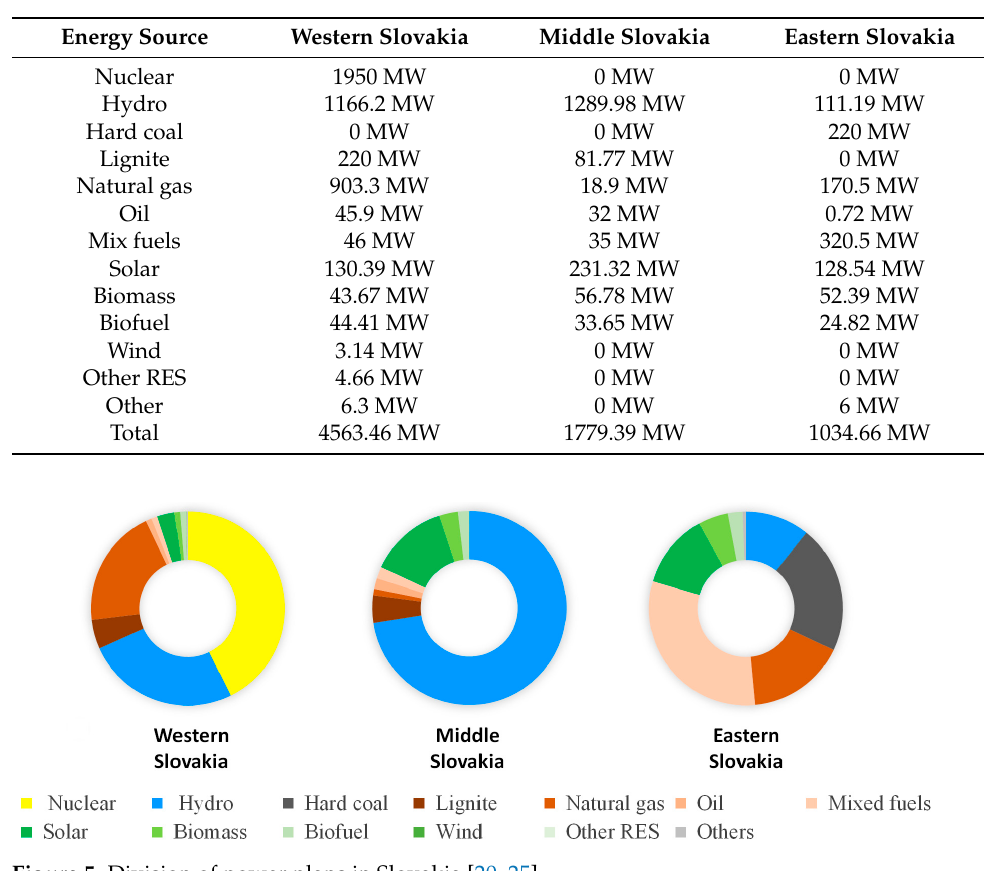
Table 1. Division of power plants in Slovakia [20–25].